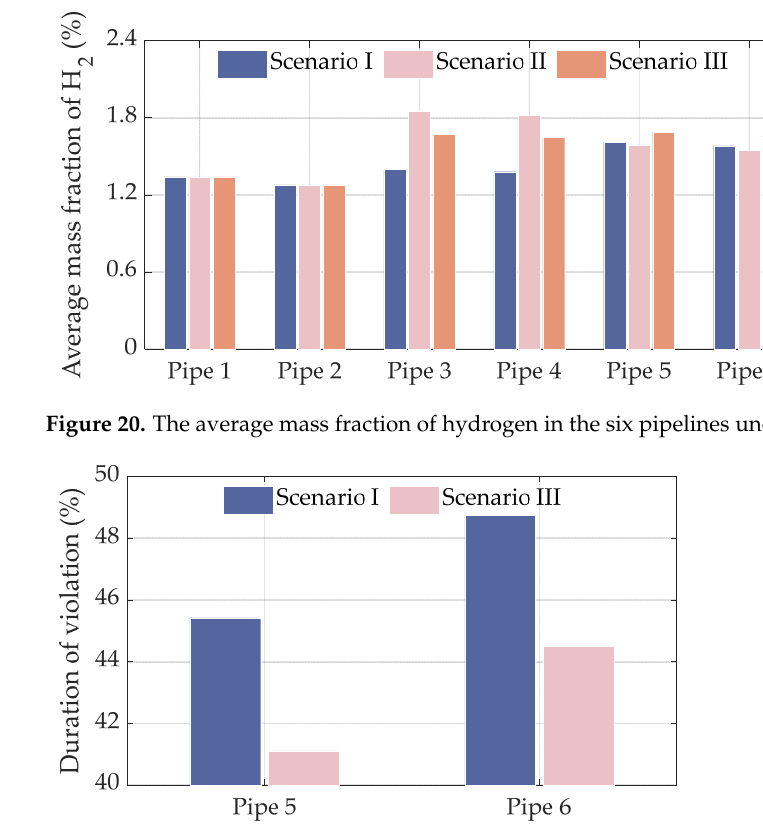
Figure 21. The duration of hydrogen concentration violation in Scenario I and Scenario